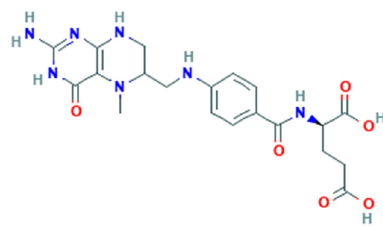
Figure 2. 5-MTHF Figure 2. 5-MTHF structure.